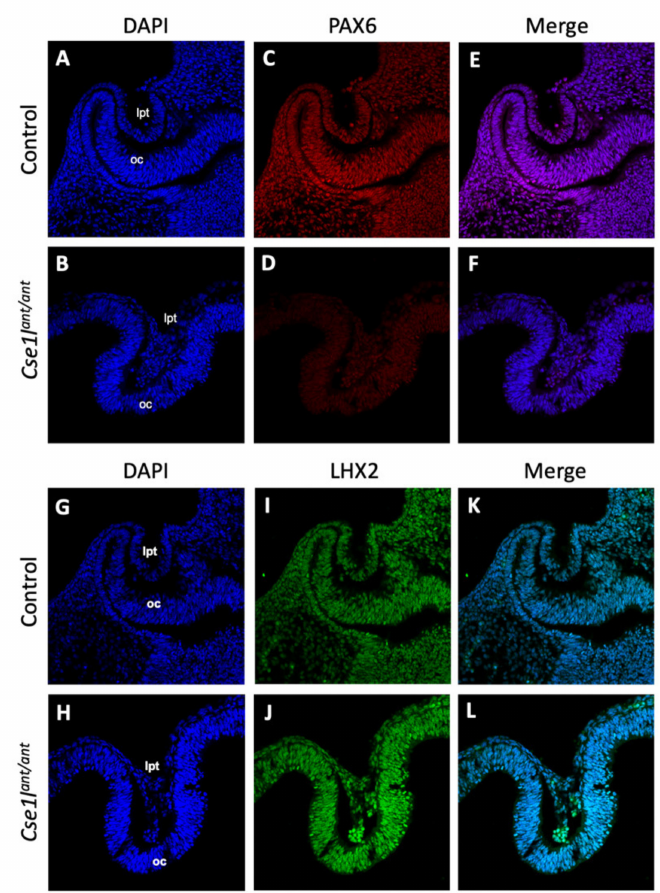
Figure 9. Pax6, but not Lhx2 expression is decreased in anteater mutant eyes. Immunohistochemistry for PAX6 ( A – F ) and LHX2 ( G – L ) indicates a marked reduction in PAX6 in Cse1l ant/ant mutants ( B – F ), but not LHX2 ( H – L ).